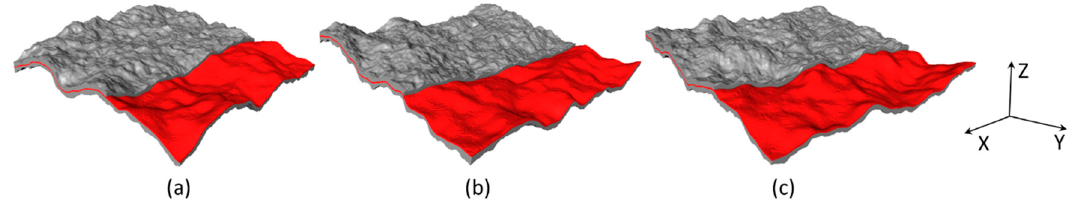
Figure 4. Three fracture models of (a–c) generated by the mean-filter method with the same input morphological parameters as described in Figure 3, where the (red) trend surface is highlight by making transparent of a region of fracture void space.